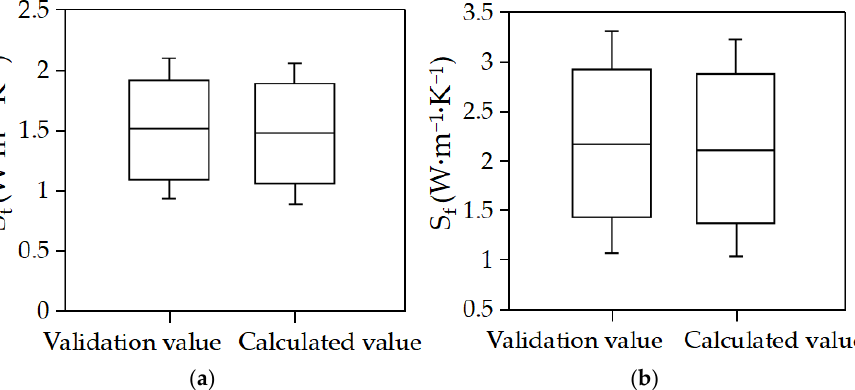
Figure 7. Comparison of the box plots of the soil thermal conductivity between the validation values (64 samples for each period) and the values calculated with the PE factors for ( a ) the thawing period and ( b ) the freezing period. Box indicates ± 3 σ .